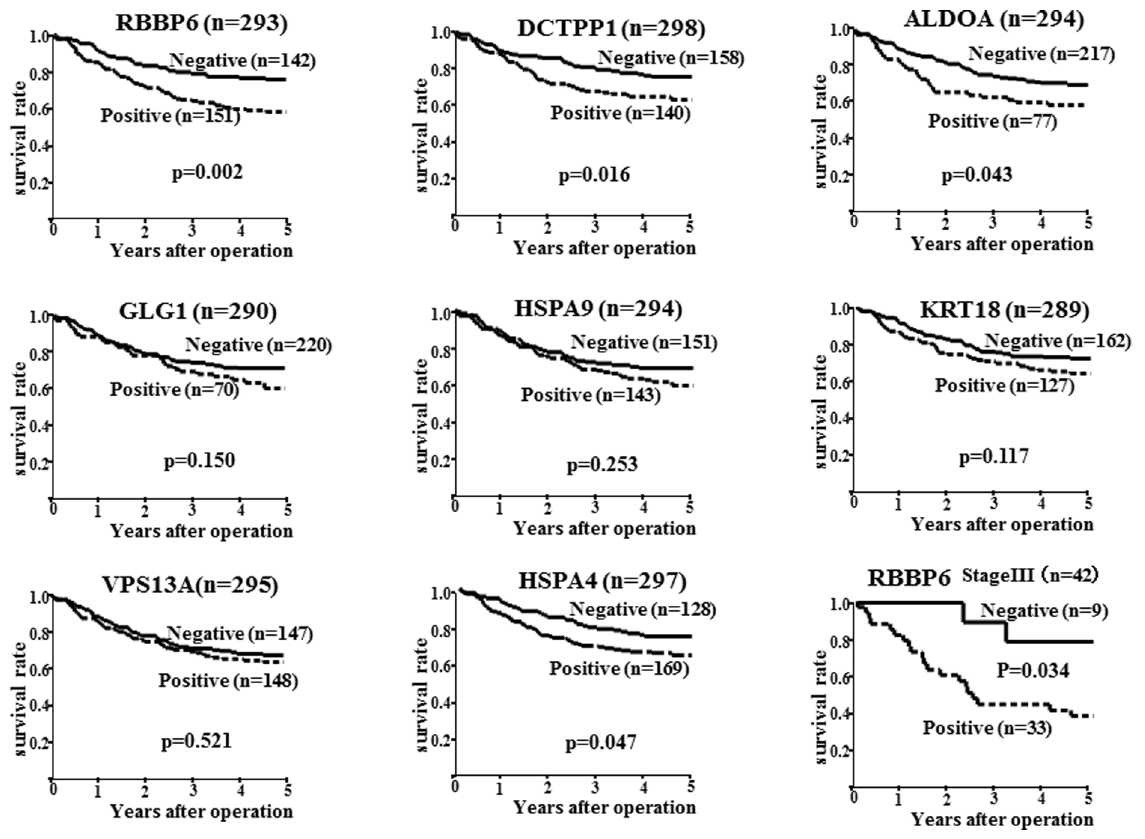
Figure 4. Overall Survival of Patients with Gastric Cancer. The overall survival of patients with gastric cancer in relation to the expression of RBBP6, GLG1, VPS13A, DCTPP1, HSPA9, HSPA4, ALDOA, and KRT18. The prognosis of patients with RBBP6, DCTPP1, HSPA4, and ALDOA expression was significantly poorer than those without expression in gastric cancer cases. The overall survival rate of RBBP6-positive cases was significantly less than that of RBBP6-negative cases in patients at stage III. In contrast, no significant correlations were observed between other proteins and patient survival.